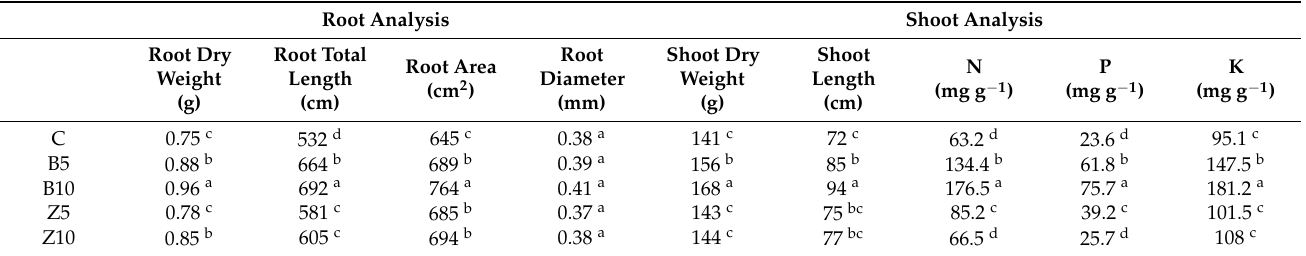
Table 3. Effect of biochar and zeolite treatments on plant growth characteristics. Root